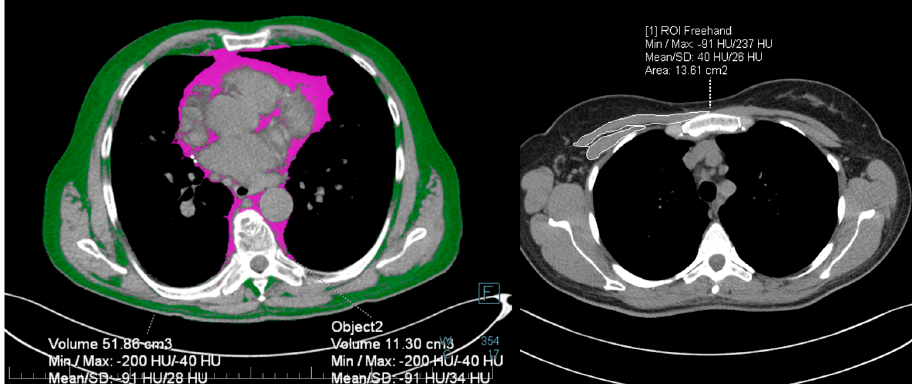
Figure 1. Thoracic fat and pectoralis muscle measurement. Intrathoracic fat (magenta) and thoracic subcutaneous fat (green) outlined at the level between the seventh and eighth thoracic vertebrae ( left ). Pectoralis muscle area outlined in white ( right ) at transverse section situated cranially from the aortic arch.